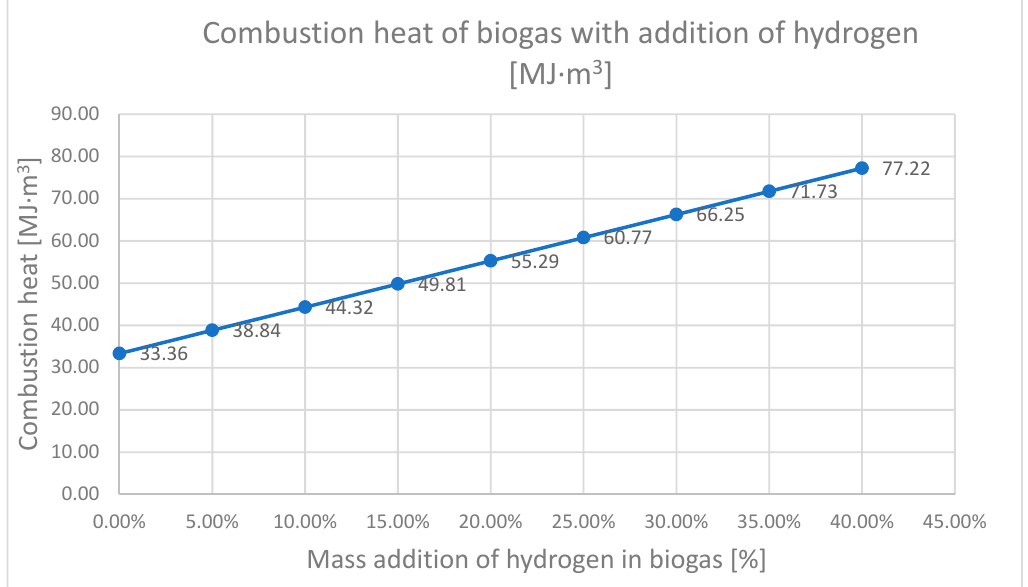
Figure 7. Change in the heat of combustion of the mixture of biogas and hydrogen with a higher mass content of hydrogen (dependence of the heat of combustion on the hydrogen content of biogas) .